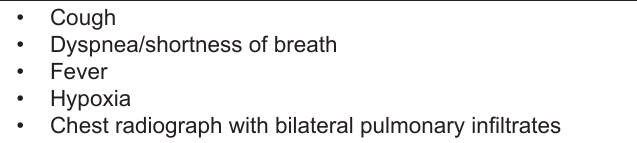
Table 1. Emergency department protocol: five clinical parameters used to determine likelihood of COVID-19 positive polymerase chain reaction